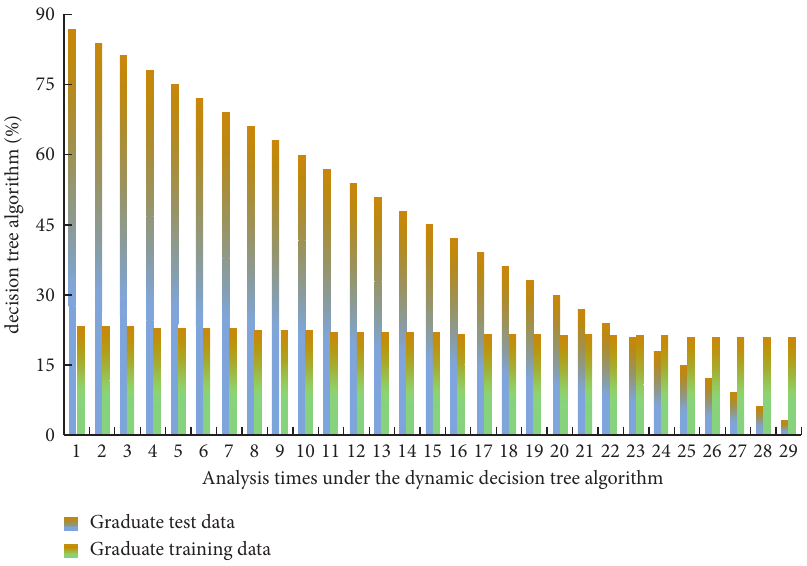
Figure 5: The simulation analysis result of the dynamic decision tree under the training data and the test